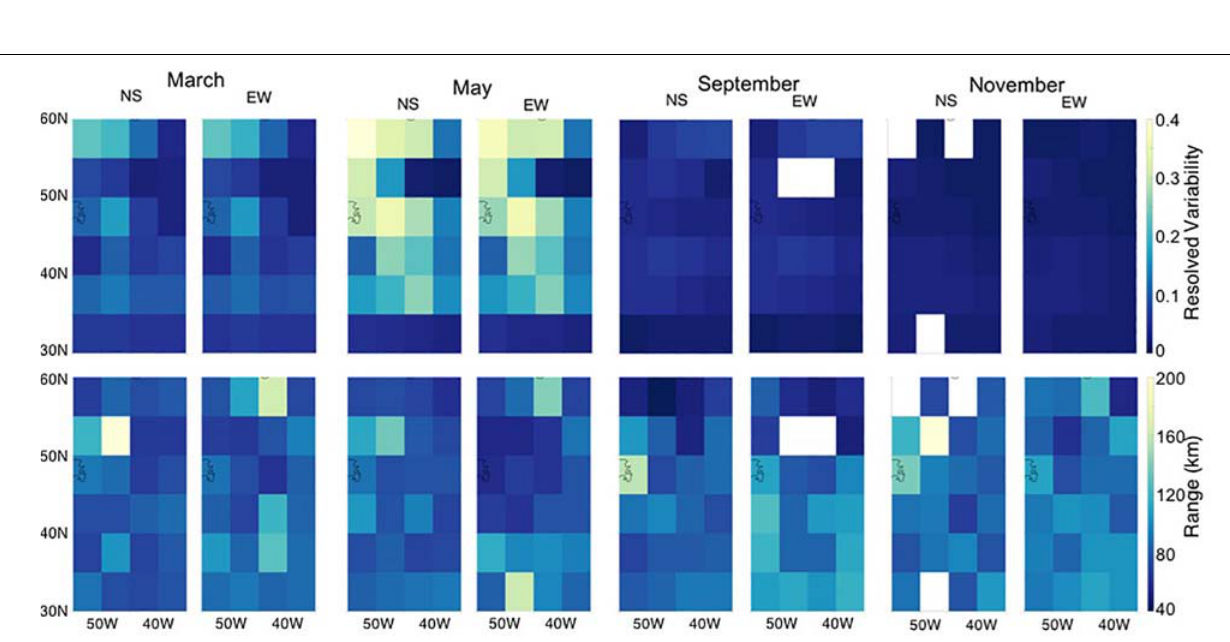
FIGURE 3 | Geostatistical analysis of chlorophyll a from the Community Earth System Model (CESM). Simulated monthly average chlorophyll a resolved variability as computed from Eq. 2 (sill, top) and range (bottom) for March, May, September, and November in 5 ◦ × 5 ◦ grid boxes for the western North Atlantic sub-region denoted in Figure 1